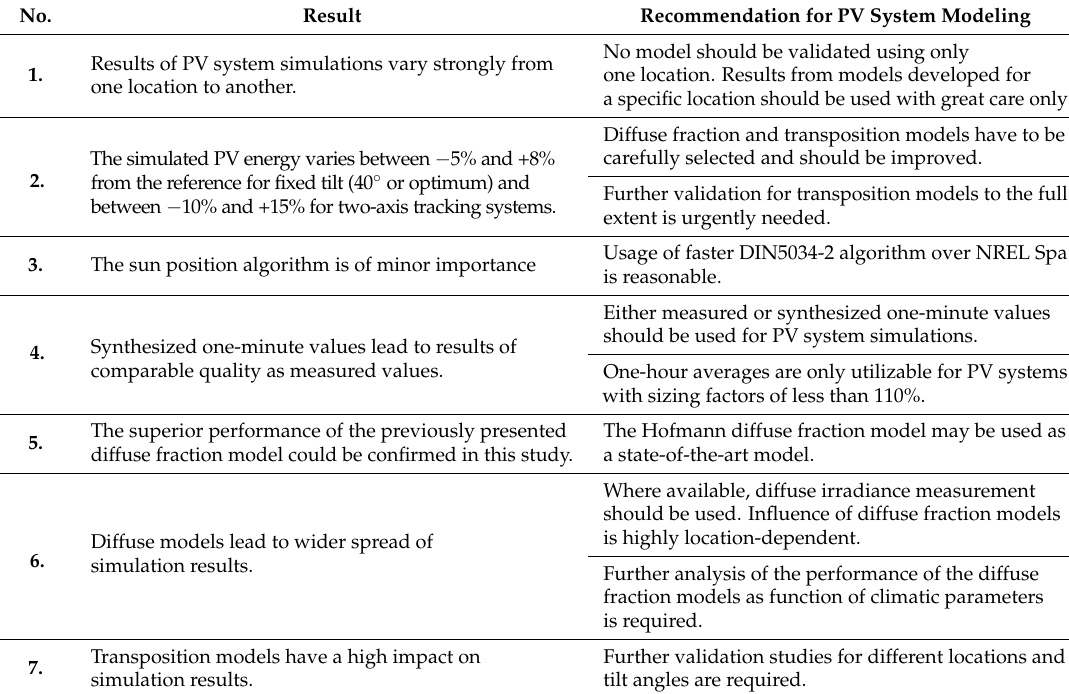
Table 5. Main results of this study and their consequences on PV